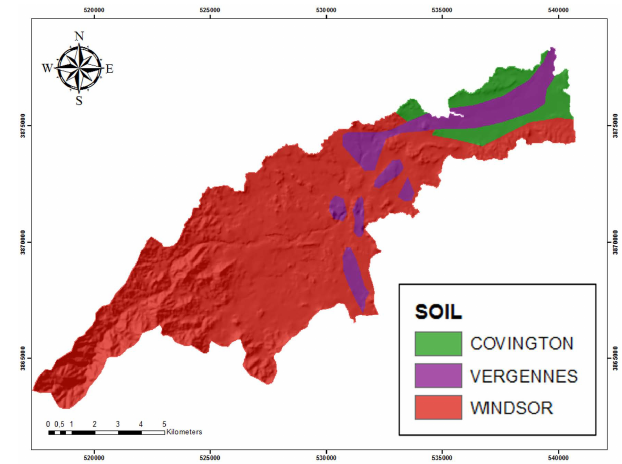
Fig. 5. Soil map of the study